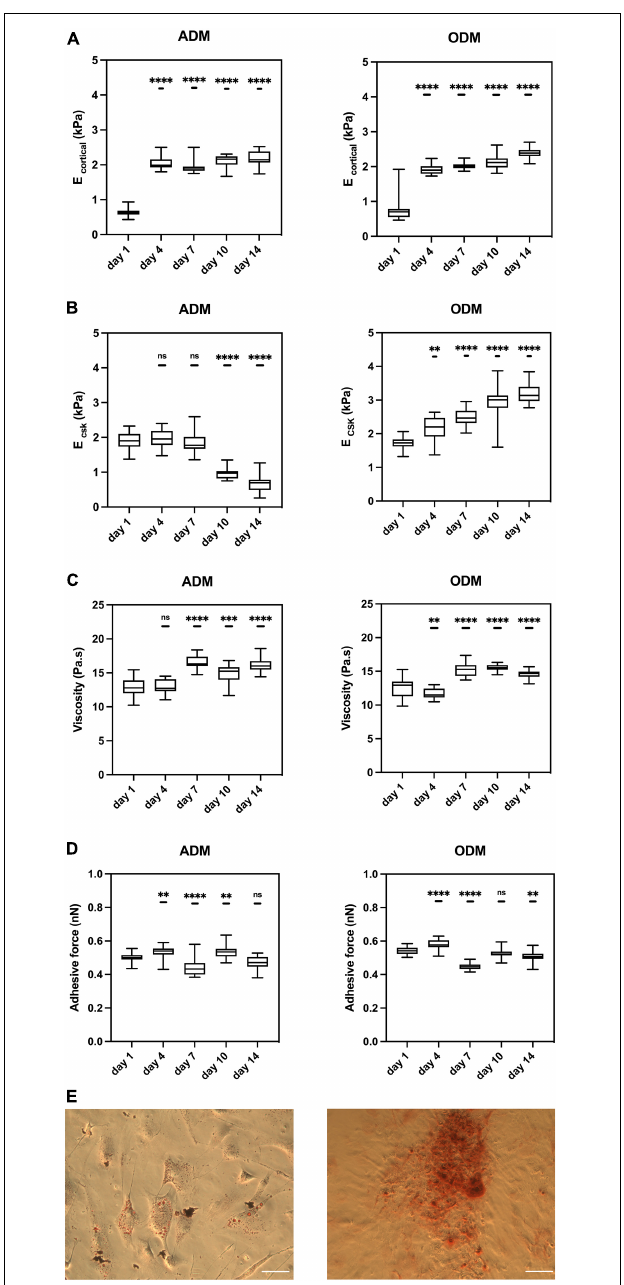
FIGURE 2 | The mechanical properties of hMSCs change during differentiation. Box plots show the results of the (A) E cortical , (B) E CSK , (C) viscosity, and (D) adhesive force of hMSCs during adipogenic/osteogenic differentiation at different time points. (E) Red oil staining (left) for ADM and Alizarin red staining (right) for ODM at Day 14. Scale bar = 1mm. Box plots extend from the 10th to the 90th percentile, whiskers from min to max. A total of n = 71 (day 1, ADM), n = 69 (day 4, ADM), n = 75 (day 7, ADM), n = 56 (day 10, ADM), n = 54 (day 14, ADM), n = 71 (day 1, ODM), n = 69 (day 4, ODM), n = 85 (day 7, ODM), n = 73 (day 10, ODM), n = 67 (day 14, ODM), and cells were analyzed from n = 4 repeats. Asterisks indicate a statistical difference ( ∗∗ P < 0.01, ∗∗∗ P < 0.001, ∗∗∗∗ P < 0.0001, and obtained using a nested 1-way ANOVA design followed by a multiple comparisons Dunnett’s test against day 1). ns indicates not significant